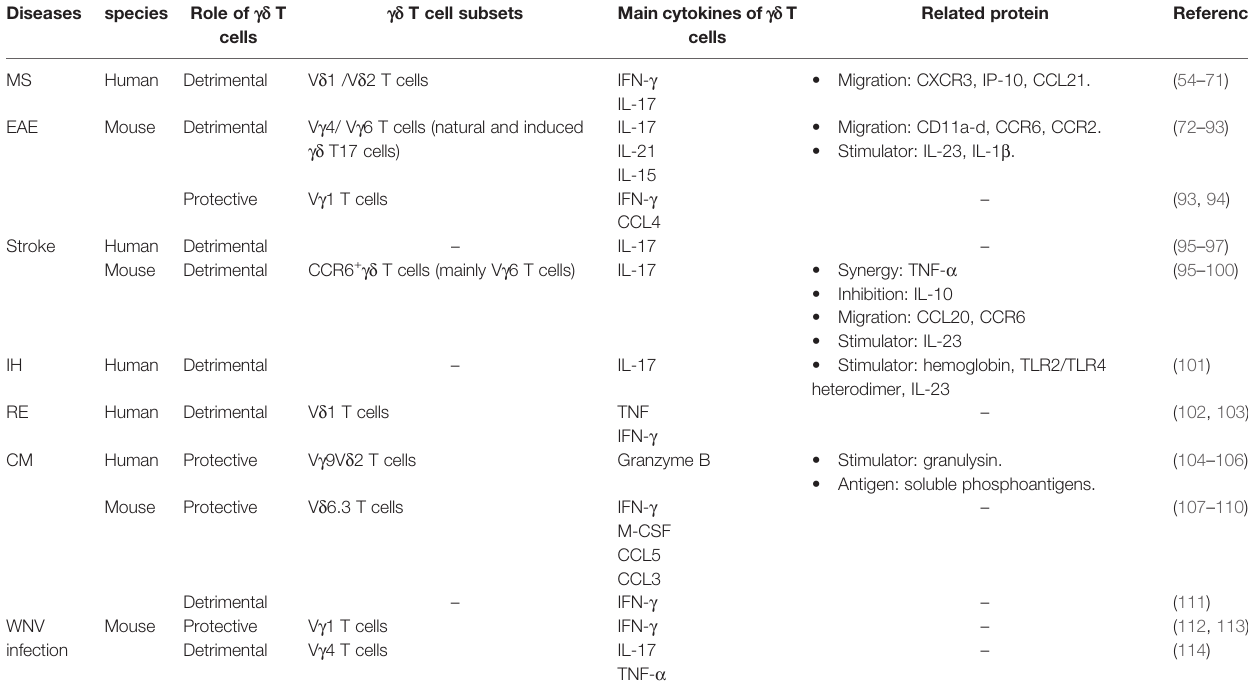
TABLE 1 | The role of gd T cells in neurological